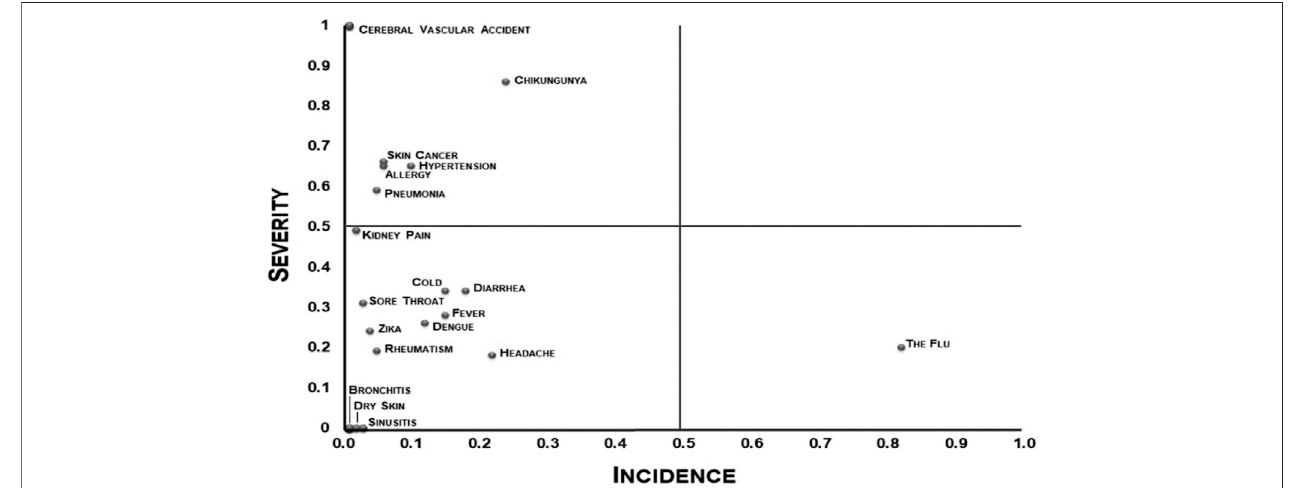
FIGURE 6 | Map of disease incidence and severity perceived by farmers in the Catimbau NAPAR.